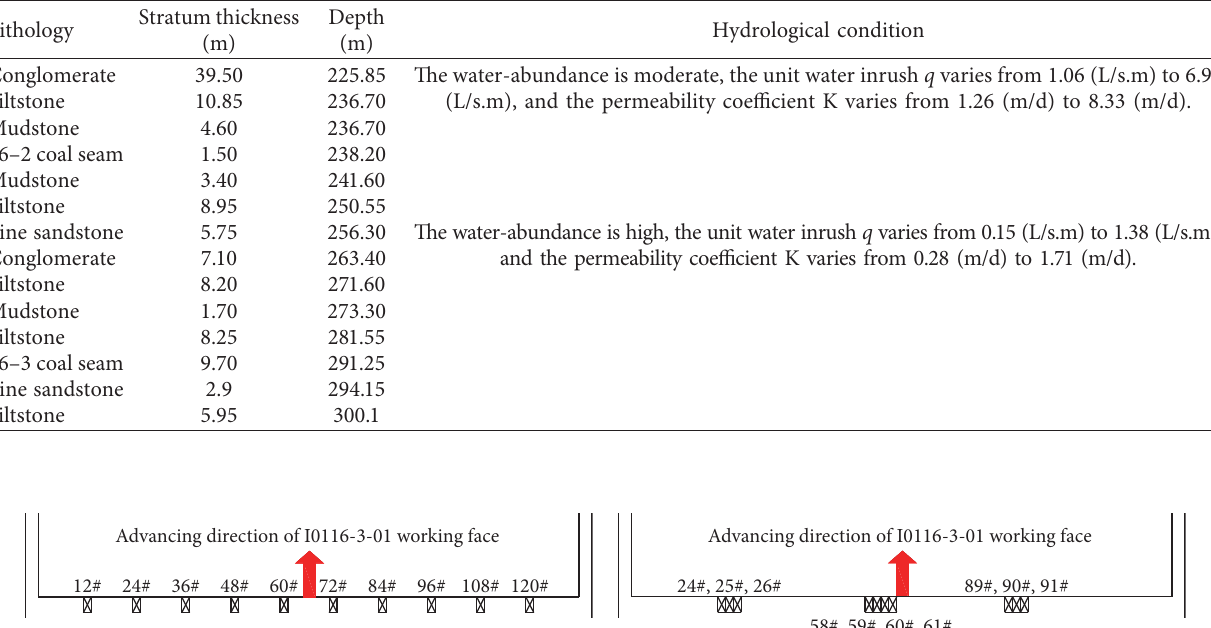
Table 1: Position relation of coal seams.